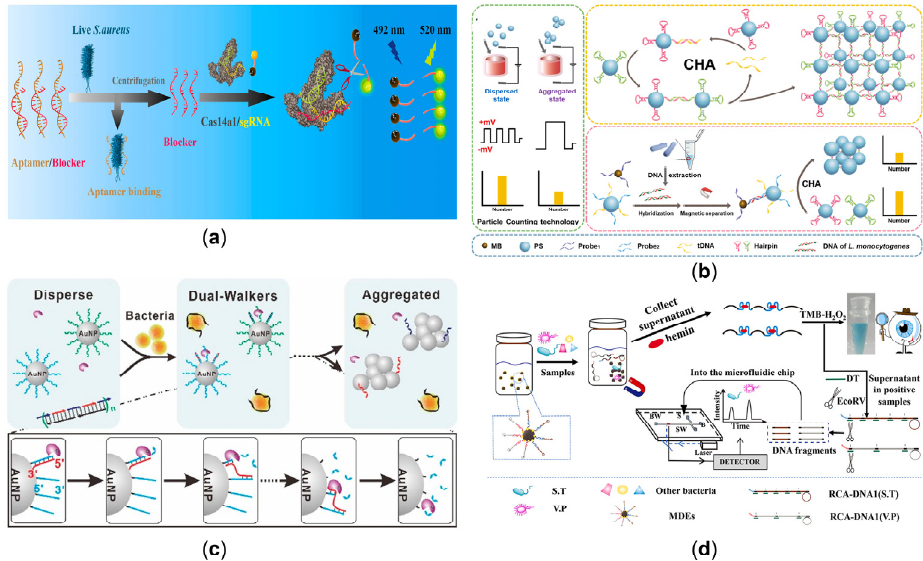
Figure 5. ( a ) The released blocker from the dsDNA triggered by the live S. aureus, combined with Cas14a1/sgRNA to cleave the FQ probe and produce an intense fluorescent signal [114]. (Reprinted from Biosensors and Bioelectronics, Wei, Y.; Tao, Z.; Wan, L.; Zong, C.; Wu, J.; Tan, X.; Wang, B.; Guo, Z.; Zhang, L.; Yuan, H.; et al. Aptamer ‐ based Cas14a1 biosensor for amplification ‐ free live pathogenic detection, 2022 , 211 , 114282, Copyright (2022), with permission from Elsevier). ( b ) The PS microspheres in different states based on the CHA ‐ mediated micro ‐ orifice resistance assay using DNA hybridization reaction to detect L. monocytogenes [116]. (Reprinted from Biosensors and Bioelectronics , Ren, L.; Hong, F.; Chen, Y. Enzyme ‐ free catalytic hairpin assembly reaction ‐ mediated micro ‐ orifice resistance assay for the ultrasensitive and low ‐ cost detection of Listeria monocytogenes, 2022 , 214 , 114490, Copyright (2022), with permission from Elsevier) ( c ) A stochastic DNA dual walker with two kinds of released multiple walking strands as a colorimetric biosensor for bacterial detection [123]. (Reprinted from Analytical Chemistry , Yang, H.; Xiao, M.; Lai, W.; Wan, Y.; Li, L.; Pei, H. Stochastic DNA Dual ‐ Walkers for Ultrafast Colorimetric Bacteria Detection, 2020 , 92 , 4990 ‐ 4995, Copyright (2020), with permission from the American Chemical Society) ( d ) A dual ‐